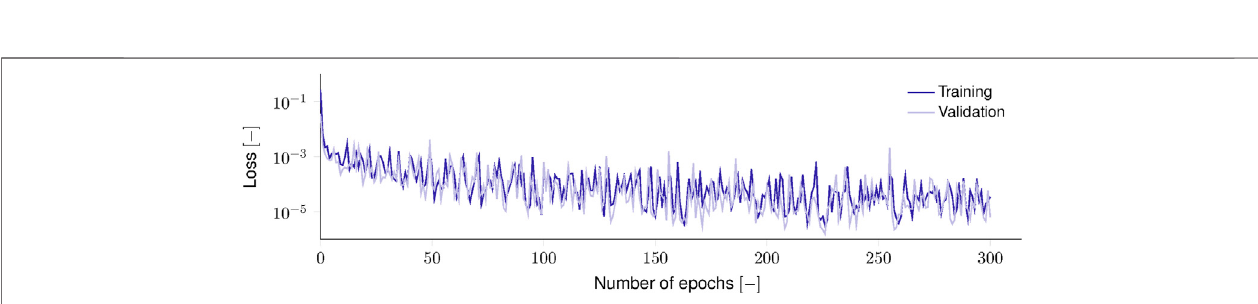
FIGURE 11 | Training and validation loss during viscoelastic constitutive model training.